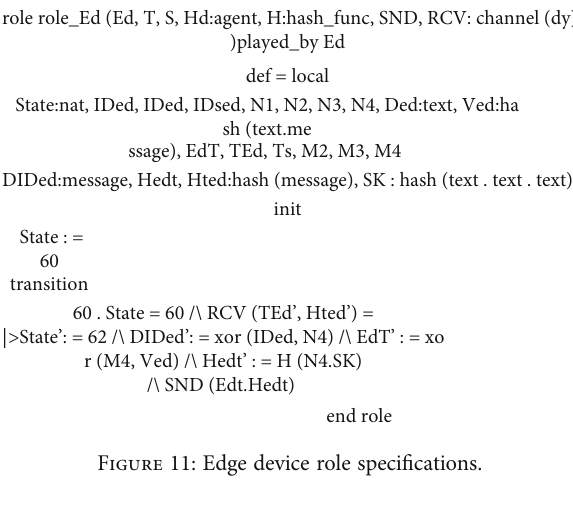
Figure 9: Server ( S ) role speci fi cations.